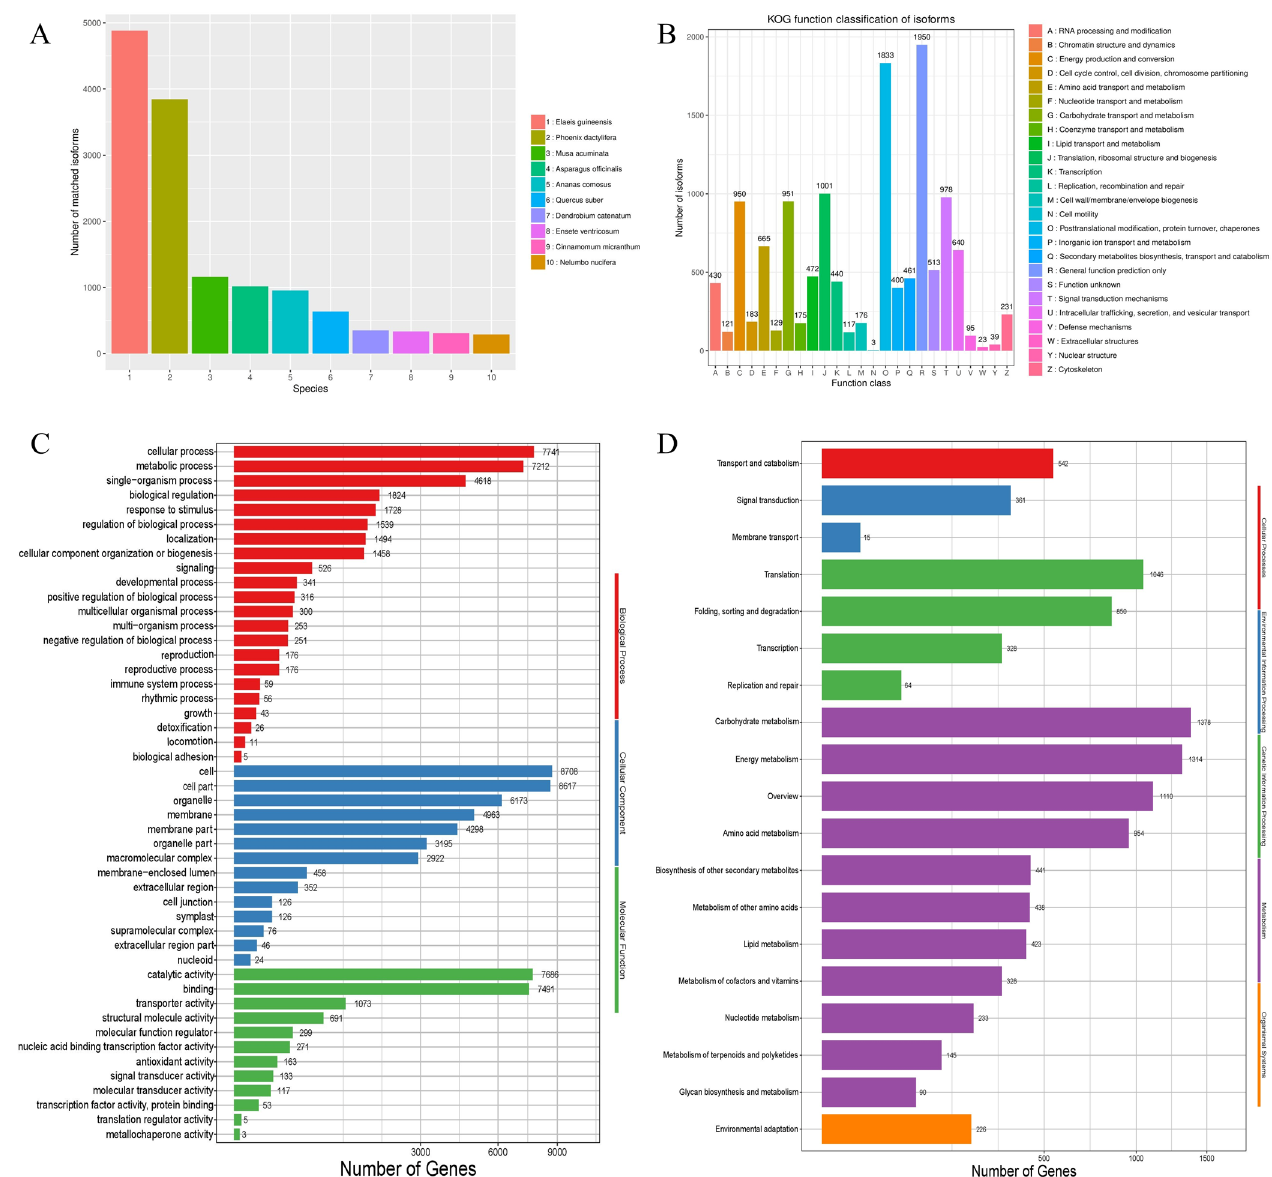
Figure 1. Species distribution annotated from the NCBI NR database ( A ), Functional annotation using the KOG ( B ), functional annotation using the GO database ( C ), and KEGG databases ( D ). GO, Gene Ontology; KEGG, Kyoto Encyclopedia of Genes and Genomes; KOG, euKaryotic Orthologous Groups.